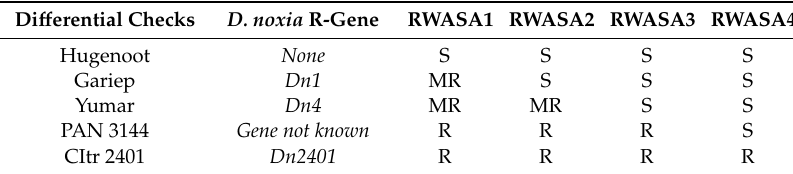
Table 6. Susceptible, di ff erential and resistant checks used in the study, the D. noxia R-genes they reportedly carry and reactions to four South African D. noxia biotypes (Adapted from [145]). A typical damage rating score of 1–3 is considered highly resistant (HR); 4, 5 is resistant (R); 6, 7 is moderately resistant (MR) and 8–10 is susceptible